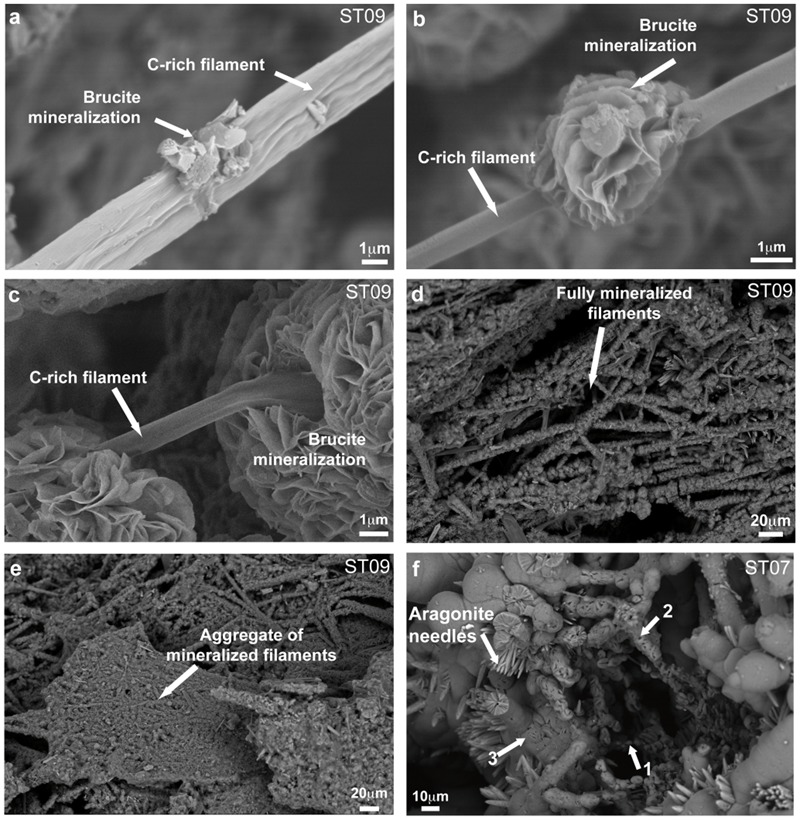
Representative SEM images of the progressive mineralization of C-rich filaments in the active conduits of a juvenile chimney sampled at site ST09 (a–e), hence leading to a compact assemblage consolidating the nascent edifice. Those are preserved in more mature chimneys as the one sampled at site ST07 (f). (a) Initial stage of mineralization with first precipitates being visible at the surface of a C-rich filament (collected at 7 kV in AsB mode). (b–c) Ongoing aggregation of brucite crystals along a filament [(b) at 7 kV, AsB mode and (c) at 3 kV, InLens mode]. (d–e) Fully-mineralized filaments forming a 3D porous structure that densified during early vent construction to form a compact chimney wall (15 kV, AsB mode). (f) Similar encrusted filaments preserved in the conduits of a mature chimney from site ST07 (15 kV, AsB mode). Note that those were the loci of subsequent mineralization following seawater circulation in the edifice (with 1–3 arrows indicating increasing mineralization steps). The deriving carbonates appeared as needles of aragonite.